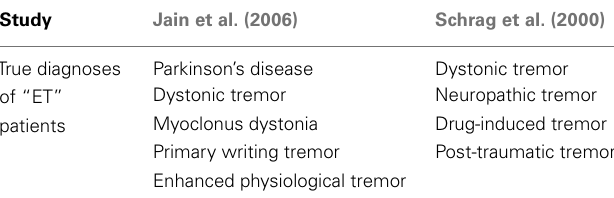
Table 4 | Essential tremor: common